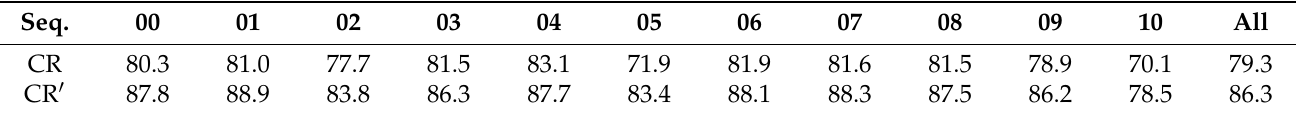
Table 4. Ratio of correctly labeled grid cells for the monocular vision